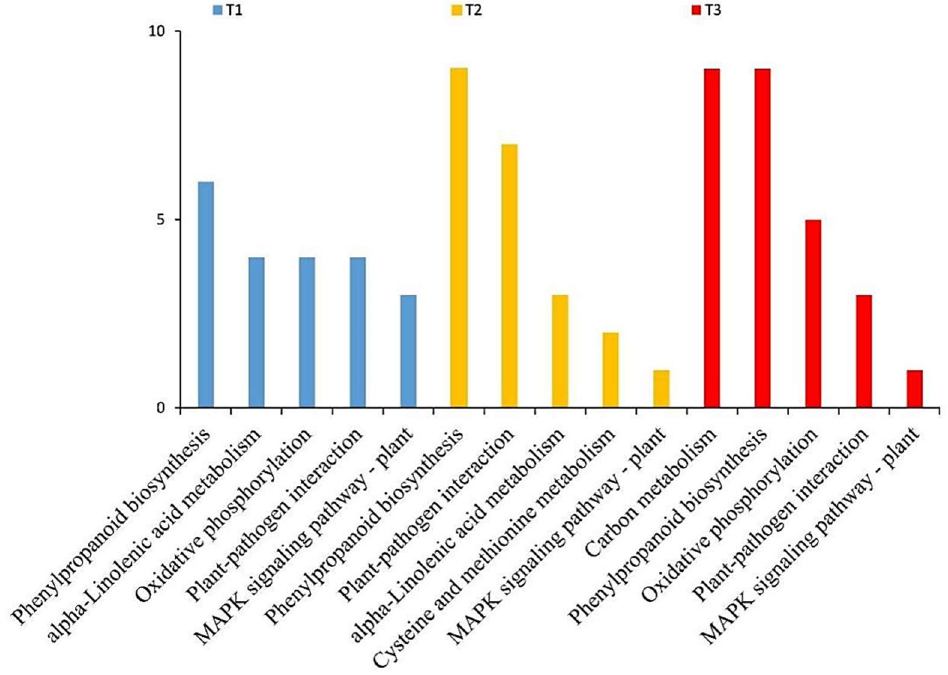
Figure 3. KEGG annotation. T1 is CK treatment at 12 hpi; T2 is CK treatment at 24 hpi; and T3 is CK treatment at 48 hpi.